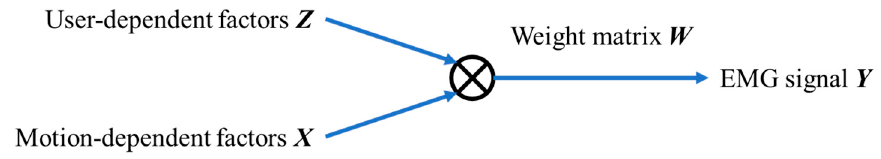
Figure 5. The composition of the EMG signal in the bilinear model.